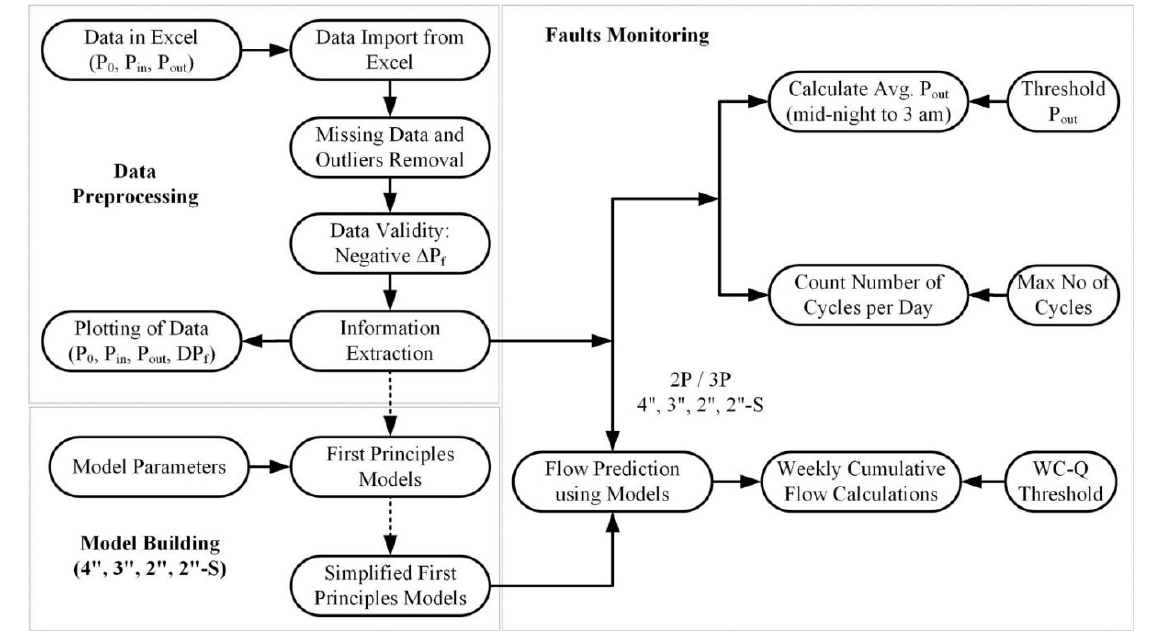
Figure 5. An overview of the developed PR fault monitoring methodologies.